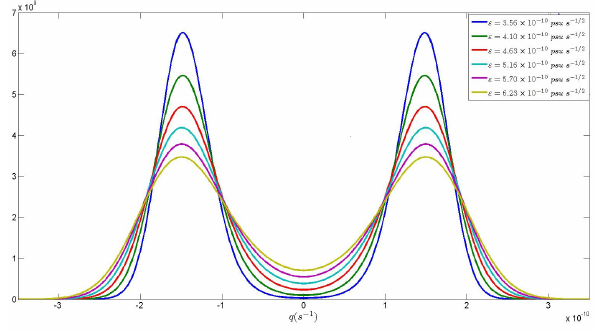
Fig. 1. Empirical probability distribution function for the THC strength in the 2 d.o.f. model for selected values of symmetrically applied